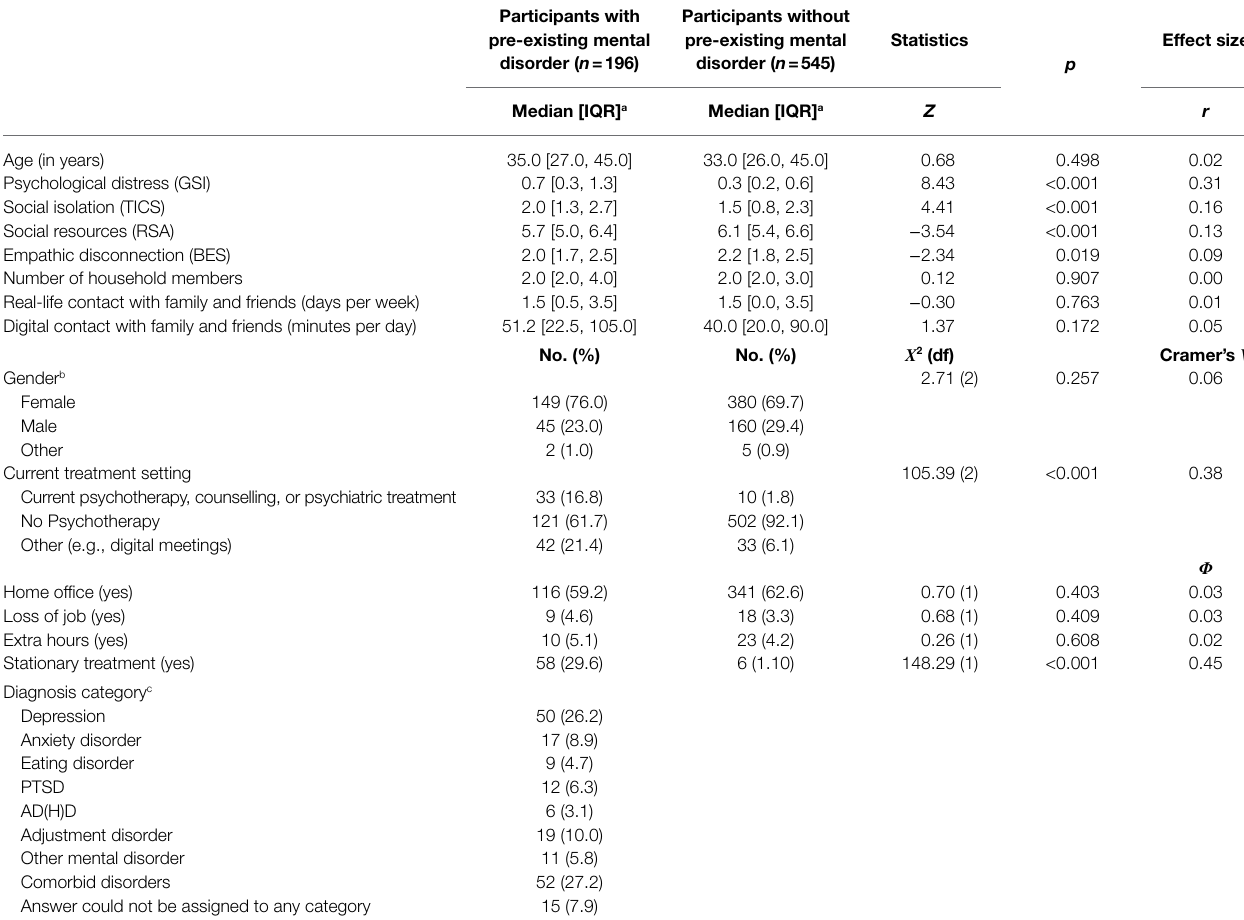
TABLE 1 | Descriptive statistics and demographics at first survey